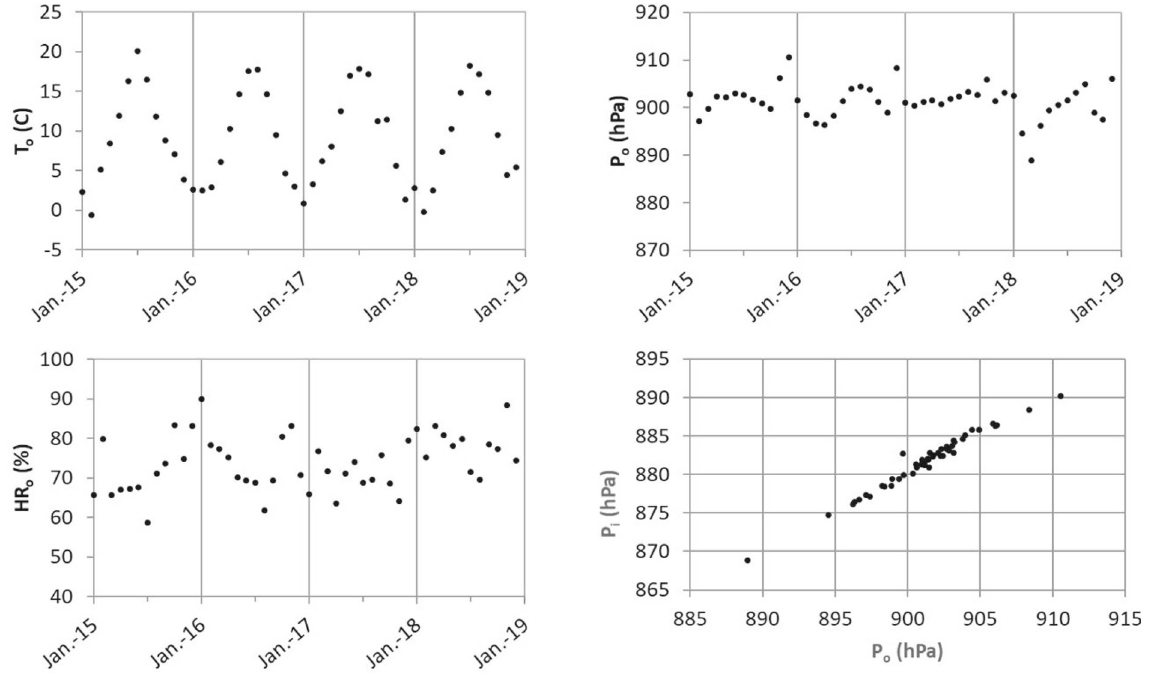
Fig. 7 MonthlyaveragesofAEMETmeteorologicaldata:temperature (upper left), pressure (upper right) and relative humidity (bottom left). The bottom right panel shows the high correlation between the atmo-